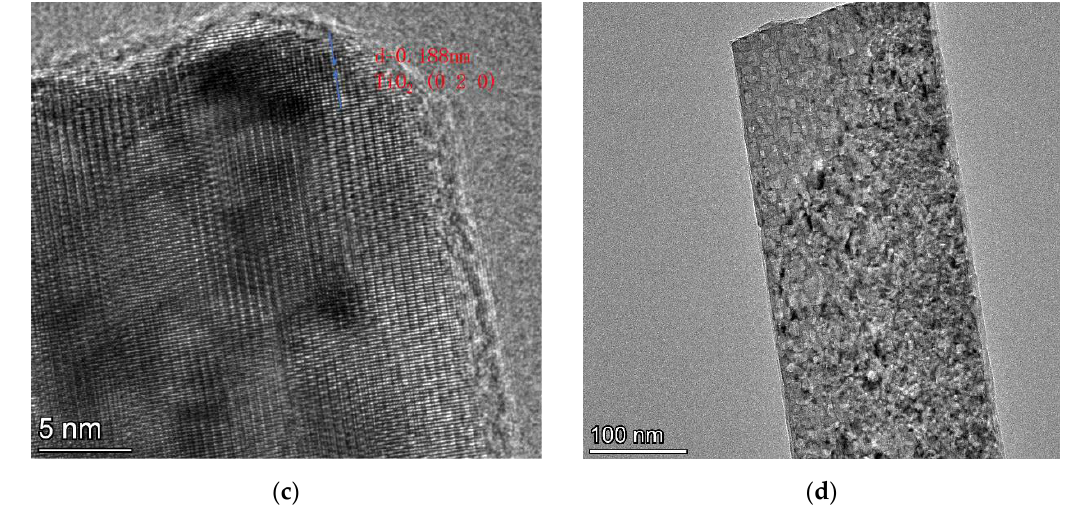
Figure 2. ( a , b ) Diffraction patterns of TiO 2 (B) nanobelt; ( c , d ) HRTEM (High-Resolution Transmission Electron Microscopy) images of TiO 2 (B) nanobelt.